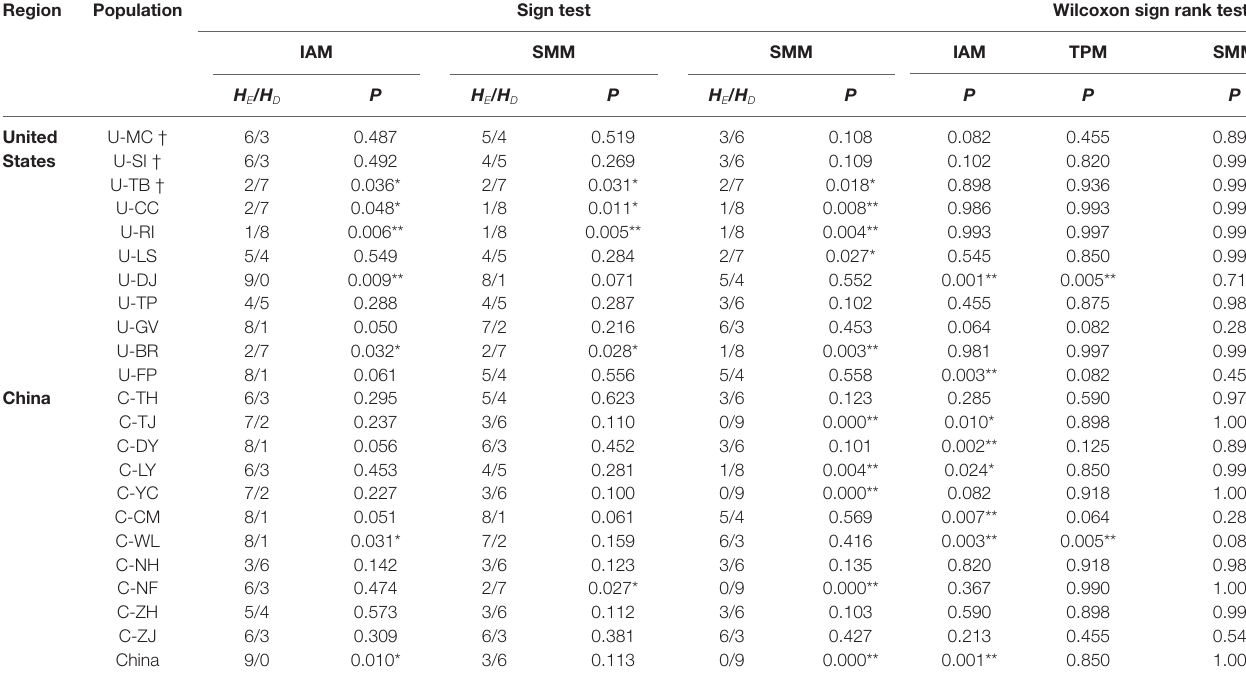
TaBle 4 | Sign test and Wilcoxon sign rank test of bottleneck estimates in S. alterniflora populations.